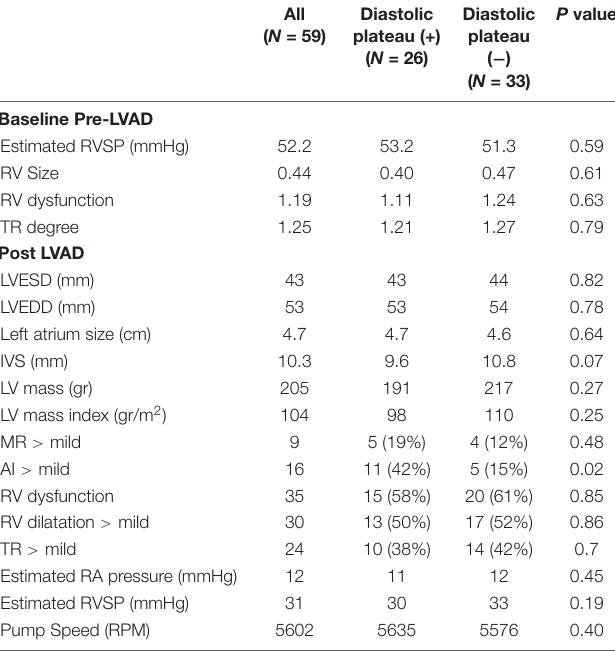
TABLE 2 | Echocardiography